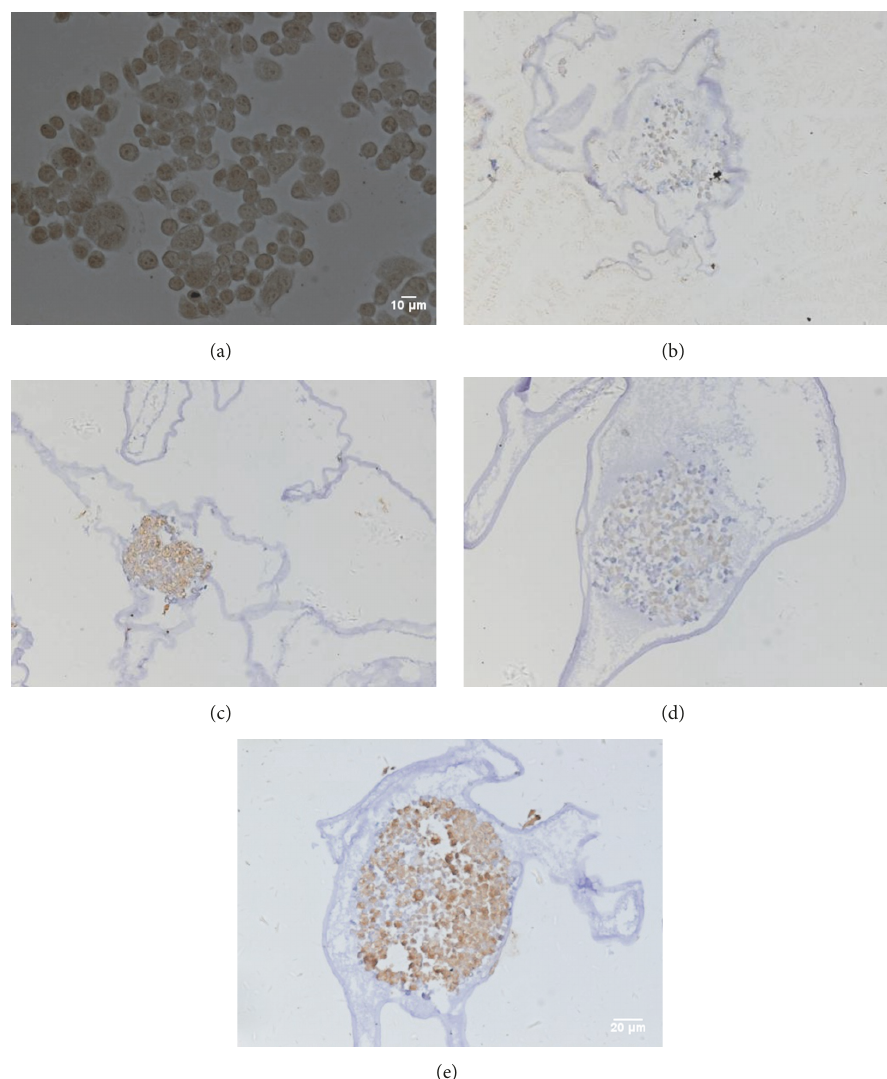
Figure 6: Expression of PCNA in the cells and spheres by H&E staining. Brown nuclei indicated positive PCNA staining. (a) Monolayer SGC9701 cells showed positive PCNA expression. (b, c) The microencapsulated cell spheres cultured for 7 days and 14 days: PCNA expression was observed throughout the entire spheres. (d) The microencapsulated cell spheres cultured for 21 days: PCNA expression was detected outside the spheres, but not in the center. (e) The microencapsulated cell spheres cocultured with macrophages for 3 days: the number and density of the spheres expressing PCNA were increased. Magnification: